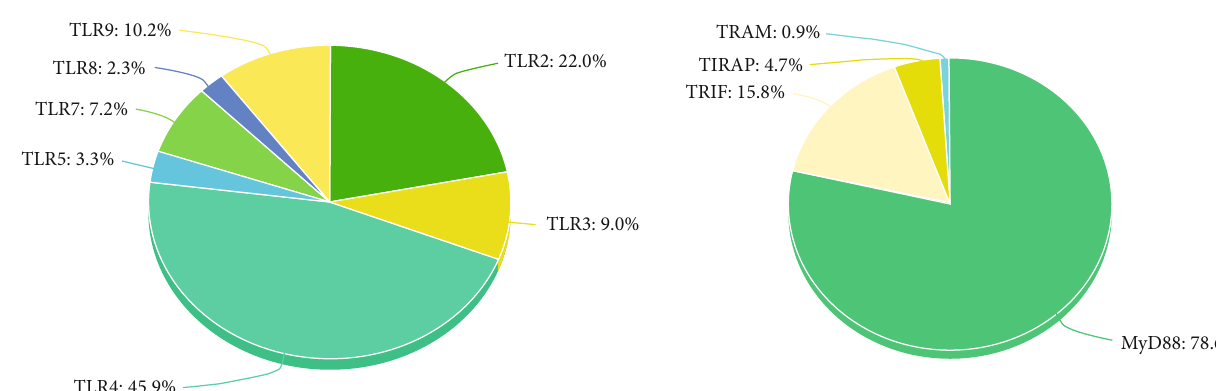
Figure 1: TLR4 and MyD88 hegemony in TLR research. The number of publications regarding each TLR and TLR-related adaptor referenced in PubMed® was calculated on 27 th October 2022. 28,034 publications regarding TLR4 were found; 13,431 on TLR2; 6,237 on TLR9; 5,516 on TLR3; 4,426 on TLR7; 2,011 on TLR5; 1,435 on TLR8; 10,148 on MyD88; 2,037 on TRIF; 601 on TIRAP; and 118 on TRAM.